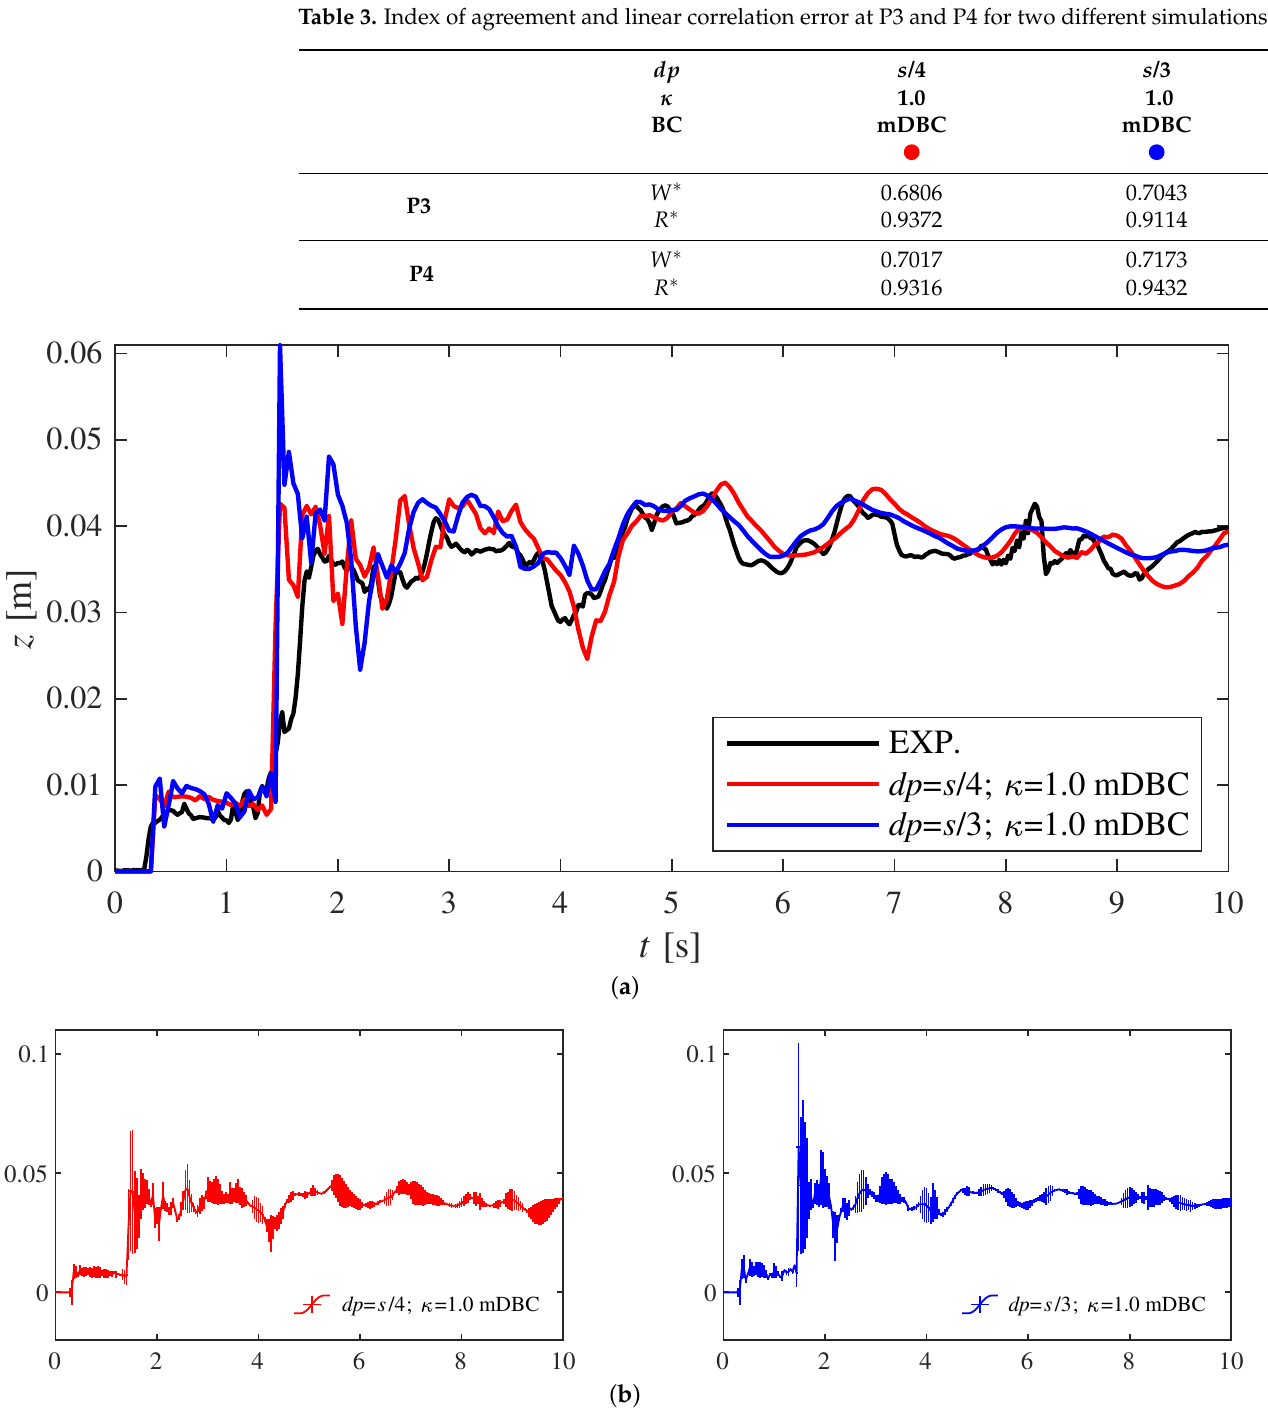
Figure 9. Comparison at P3 ( a ) and relative local elevation error ( b ) with with mDBC and different